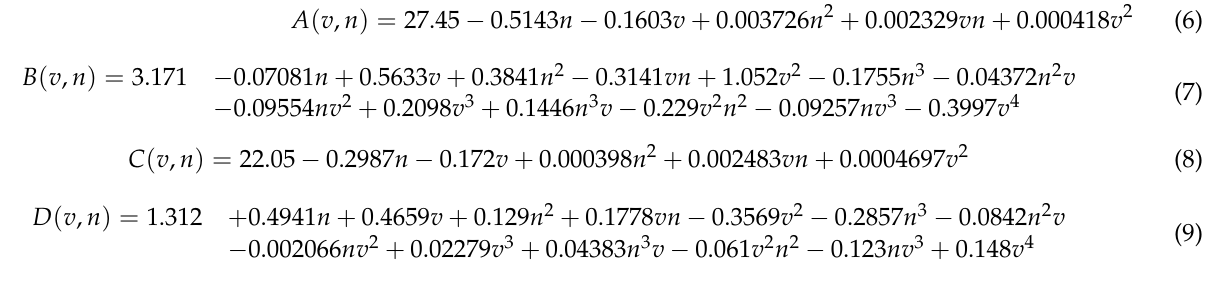
Table 4. Coefficient term and constant term of in-plane forces under different process parameters.